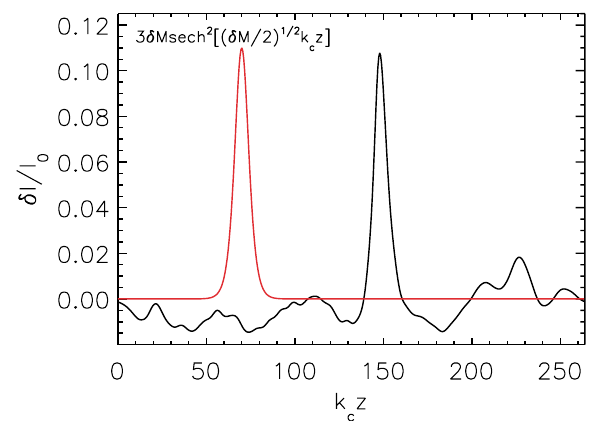
FIG. 5. (Color) Line density obtained from the Vlasov simula- tion at t (cid:2) 18 t break (black line) and Eq. (20) with d M (cid:2) 0.037 (red line).